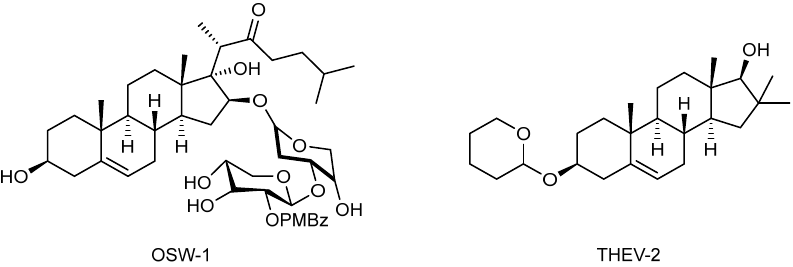
Figure 18. Chemical structures of the OSBP inhibitors OSW ‐ 1 and THEV ‐